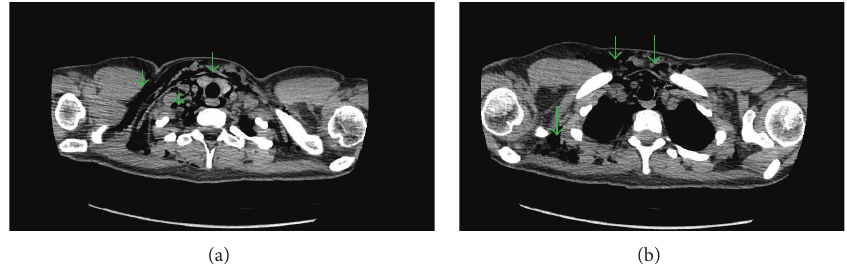
Figure 2: These images are obtained from CT thorax without contrast (mediastinal window) which confirms the findings in the chest X-ray (Green arrows).